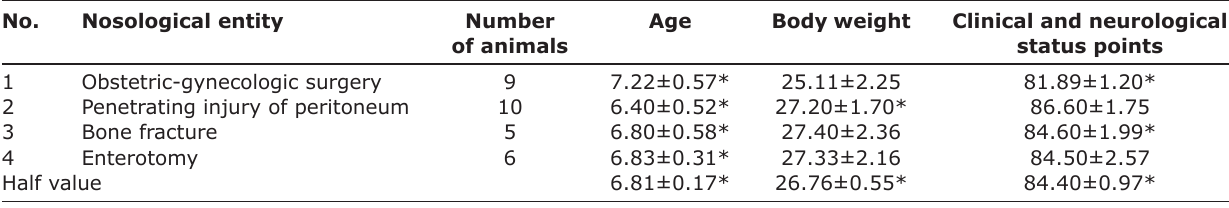
Table-1: Clinical characteristics of dogs in the experimental Group 2 on the 1 st day of the study, n=30 (M±m).